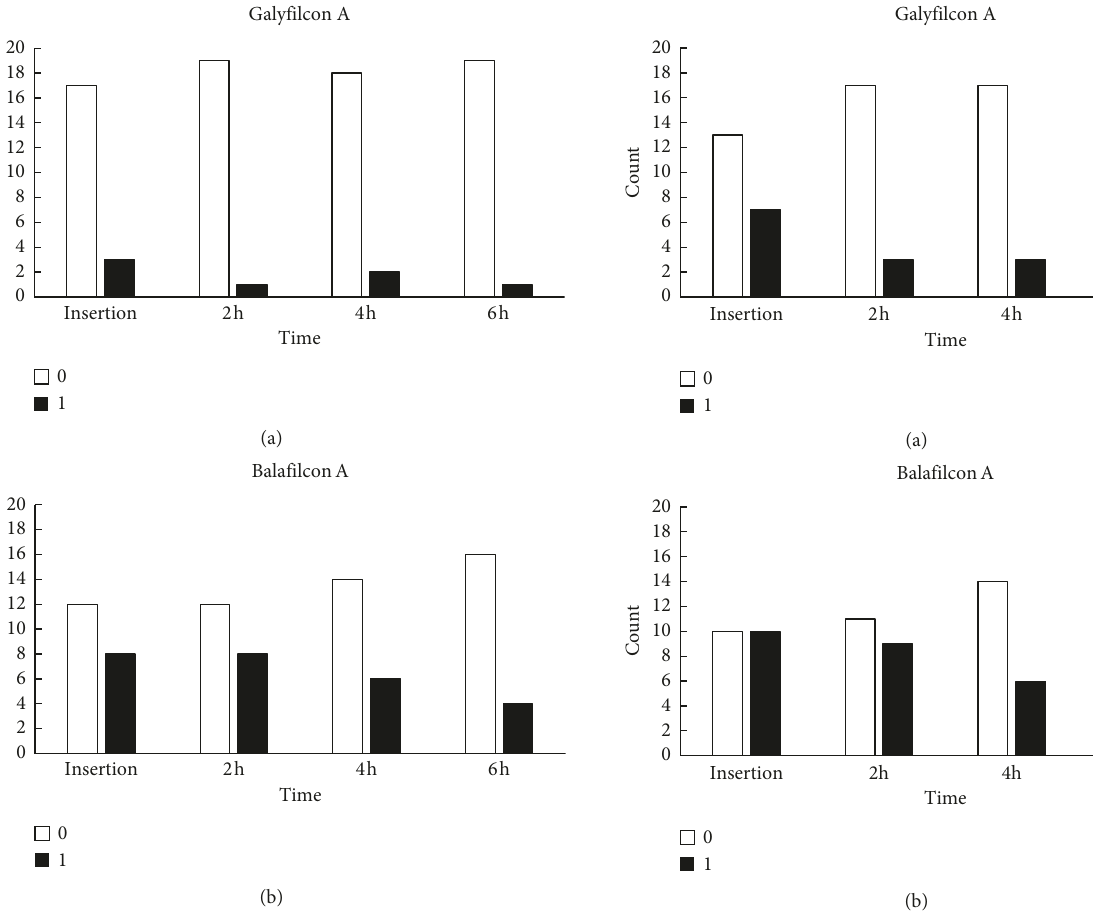
Figure 4: Time-dependent changes in PoLTF on the cornea. It was ranked as “1” if a gap was presented on the cornea and “0” as the gap was absent. (a) Time-dependent changes in PoLTF on the cornea for galyfilcon A lenses and (b) balafilcon A lenses. Fre- quency of occurrence for PoLTF on the cornea decreased over the study period compared to